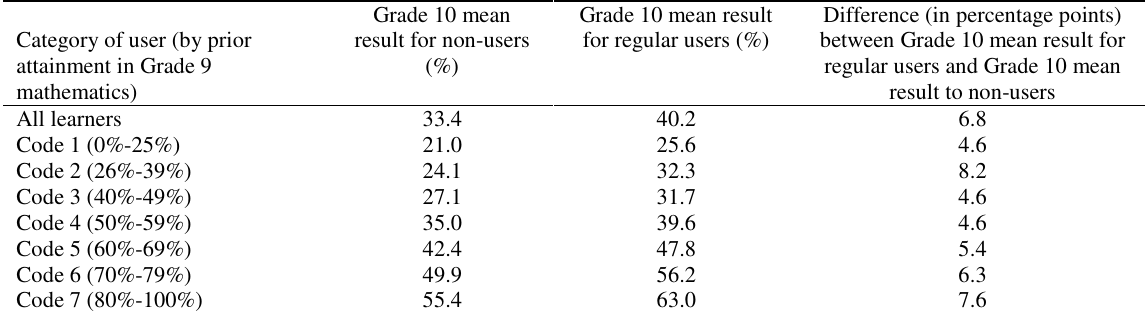
Table 2 Difference between mean attainment in Grade 10 Mathematics, comparing regular users to non-users of the